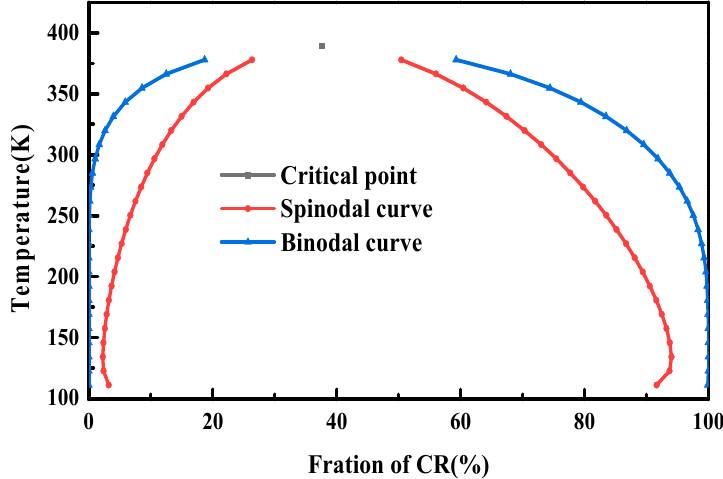
Figure 5. Phase diagram of the NR/CR blending system.